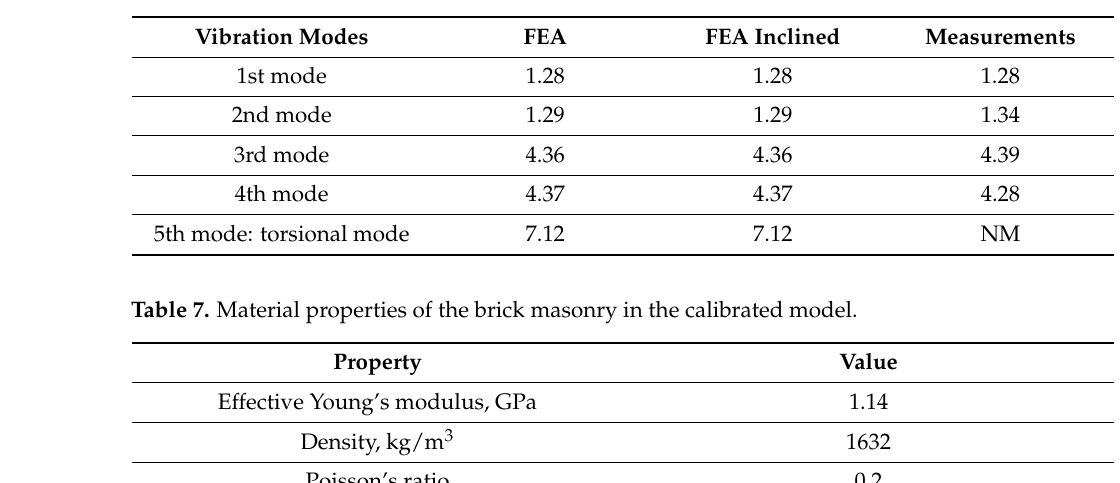
Table 6. Resonant frequencies of the numerical model compared to ambient vibration test results.